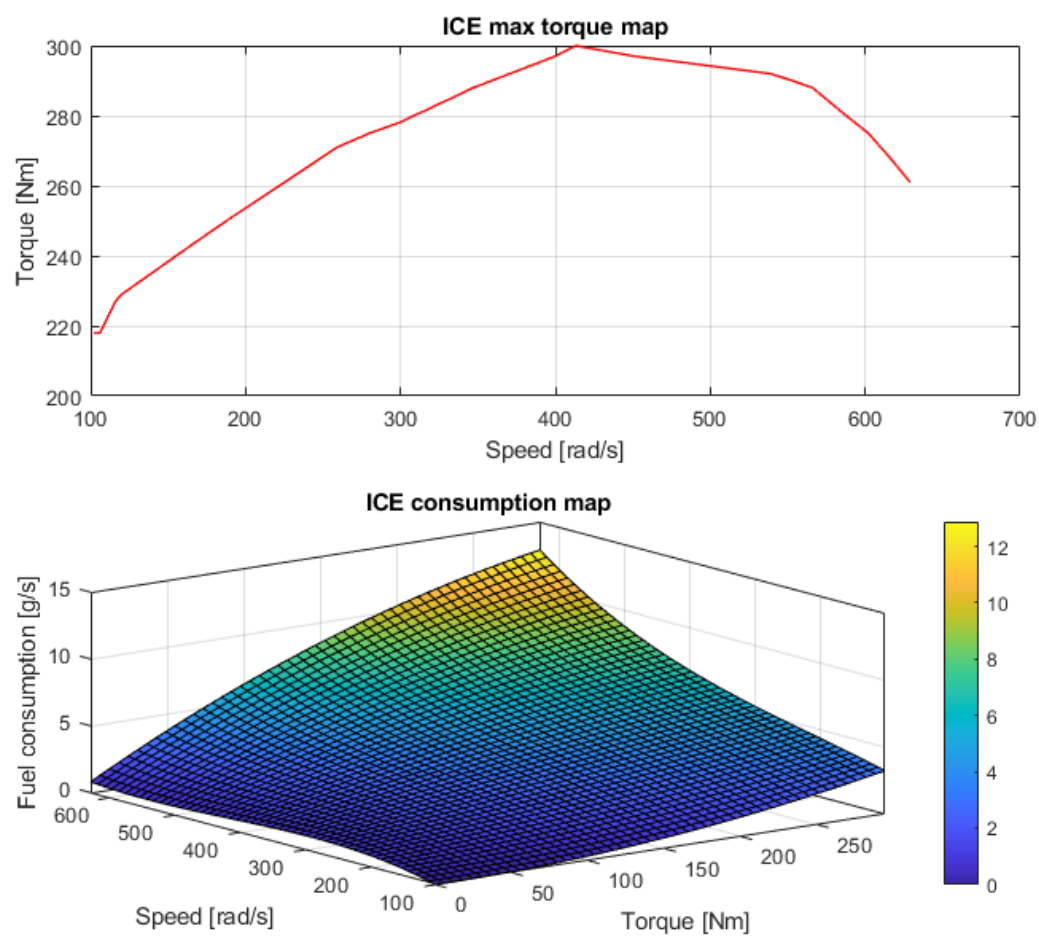
Figure 2. Maximum torque map and consumption map of the ICE adopted in the simulation.